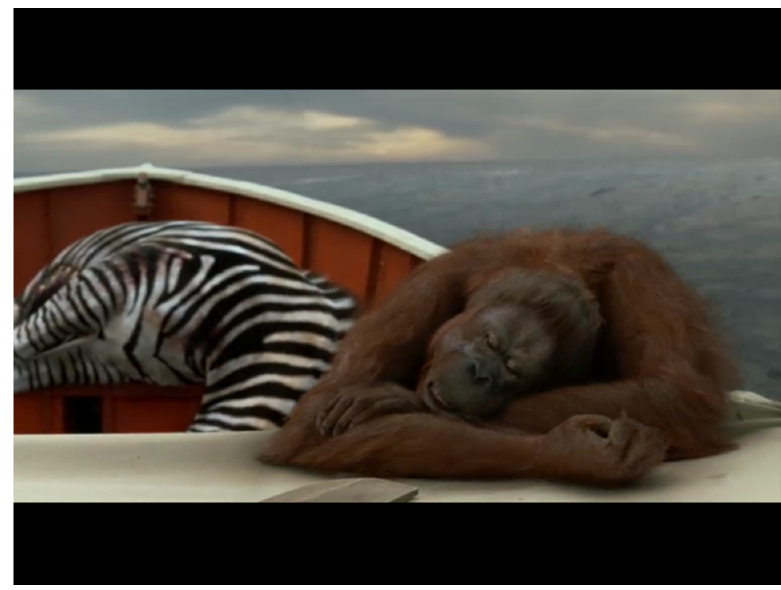
Figure 10. Digitally rendered animals in Pi’s lifeboat.